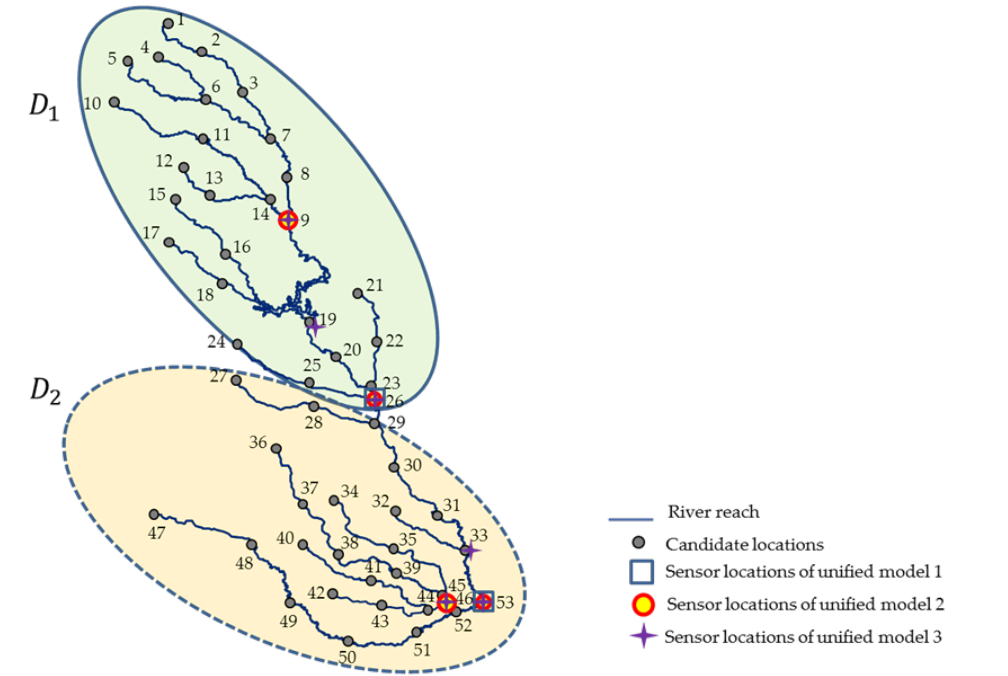
Figure 8. Candidate locations of a spill event and of sensor locations [15].